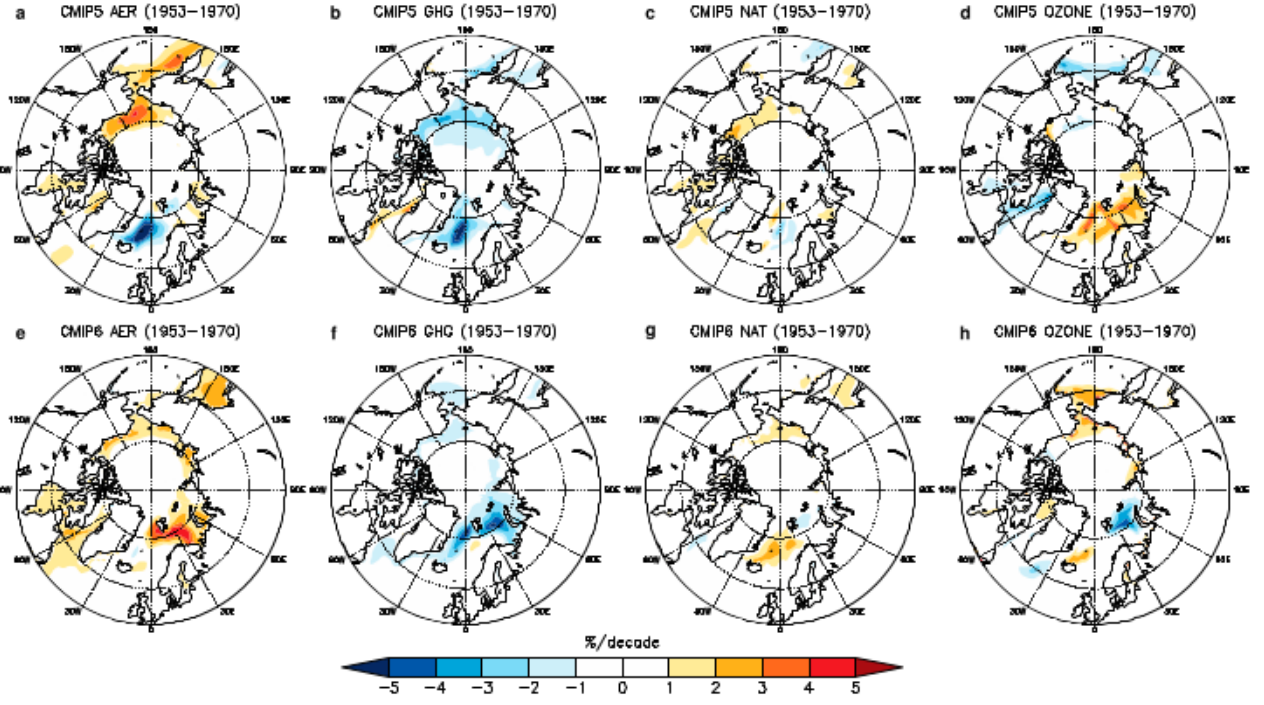
Figure 5. ( a – d ) Linear trends of annual mean sea ice concentrations (shading in percent/decade) for the MMMs of CMIP5 ( a ) AER, ( b ) GHG, ( c ) NAT, and ( d ) OZONE simulations during 1953–1970. ( e – h ) Same as ( a – d ) but for CMIP6